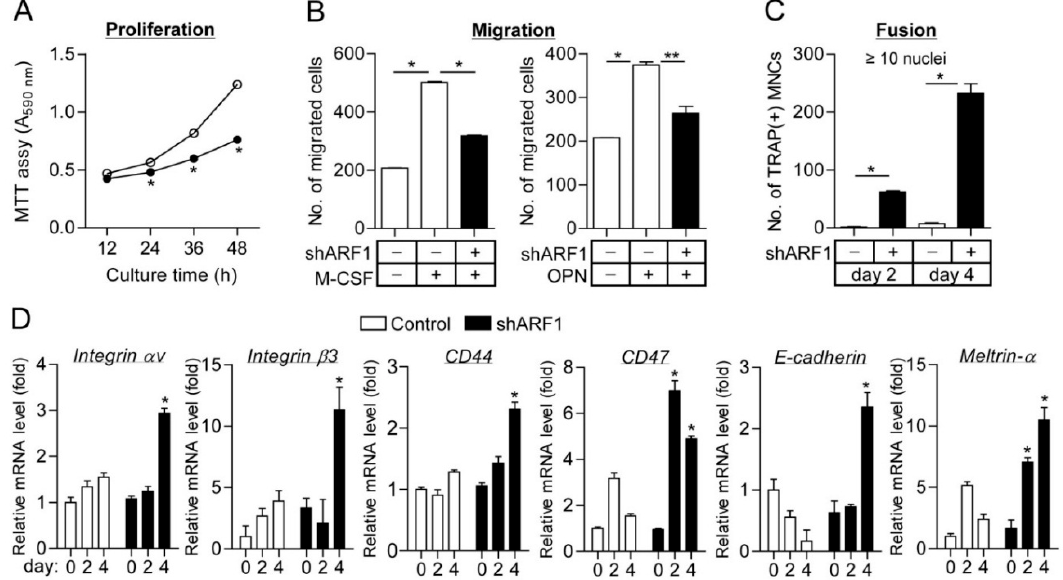
Figure 3. Proliferation, migration, and fusion assay in ARF1-deficient cells. ( A ) Osteoclast precursors infected with ARF1 shRNA lentiviral particles (closed circles) or pLKO.1-puro empty control particles (open circles) were cultured with M-CSF (30 ng/mL) for the indicated times, followed by colorimetric MTT assay; ( B ) Cell migration was determined using the Transwell migration chambers as described under “Materials and methods”. Osteoclast precursors were seeded onto the upper chamber, and M-CSF (30 ng/mL) or osteopontin (OPN, 100 ng/mL) was added to the lower chamber. The number of migrated cells was counted under a light microscope; ( C ) Cell fusion assay. BMMs with 100% confluence were treated with M-CSF (30 ng/mL) and RANKL (100 ng/mL) for 2 or 4 days and then stained for TRAP. TRAP(+) MNCs with more than 10 nuclei were counted using a light microscope. As in ( A – C ), data are mean ± SD ( n = 3). * p < 0.01, ** p < 0.05; ( D ) Expression levels of fusion-related genes, including α v β 3 integrin, CD44, CD47, E-cadherin, and Meltrin- α , during osteoclast differentiation were analyzed using quantitative real-time PCR. The quantitative data between groups were analyzed by one-way ANOVA comparison. * p <